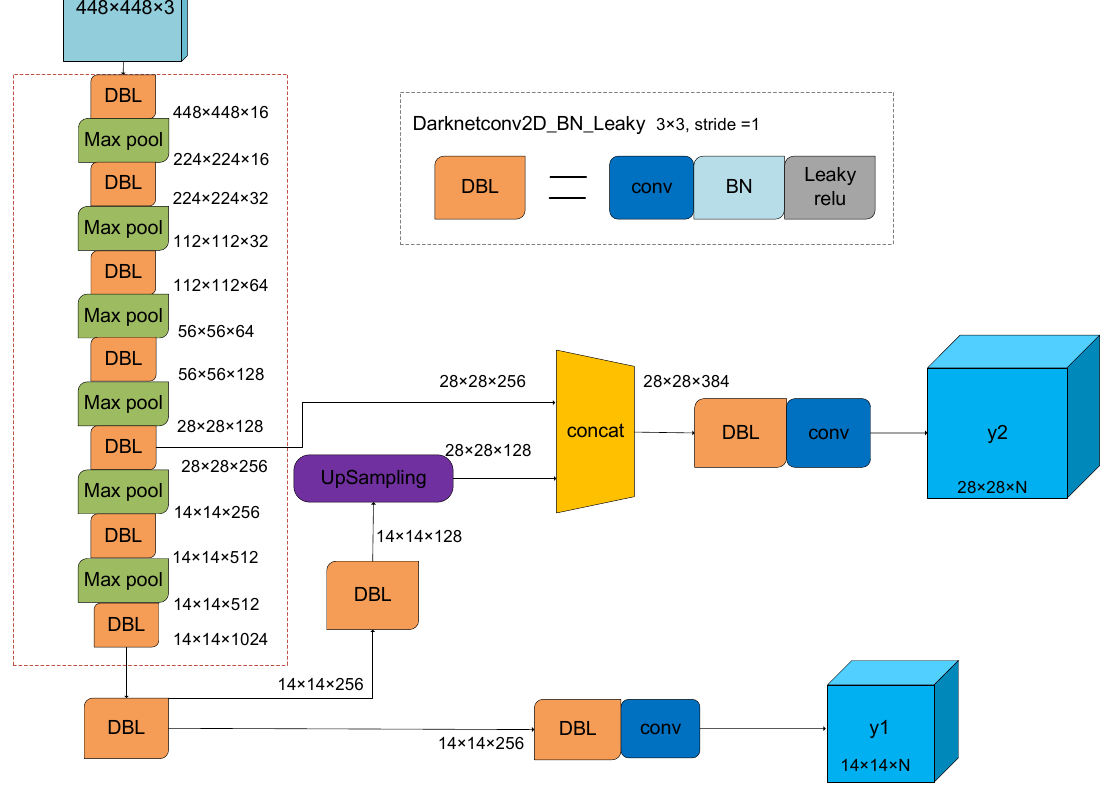
Figure 1. YOLOv3-tiny network structure.